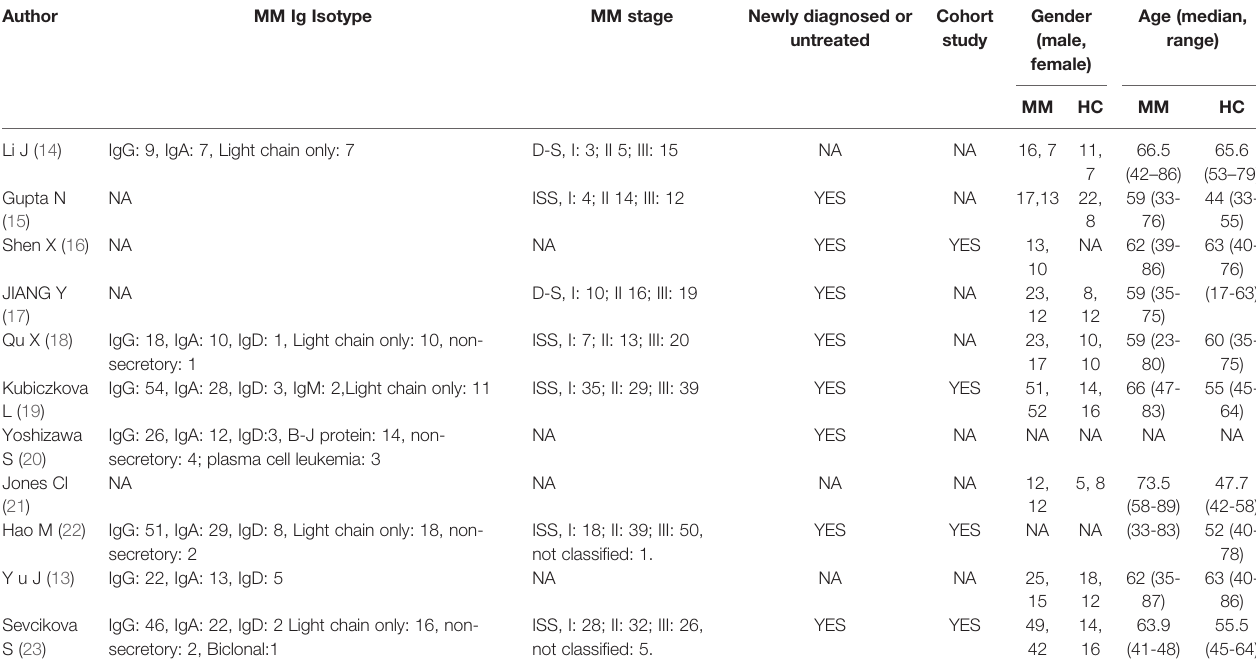
TABLE 2 | Characteristics of patients and health controls